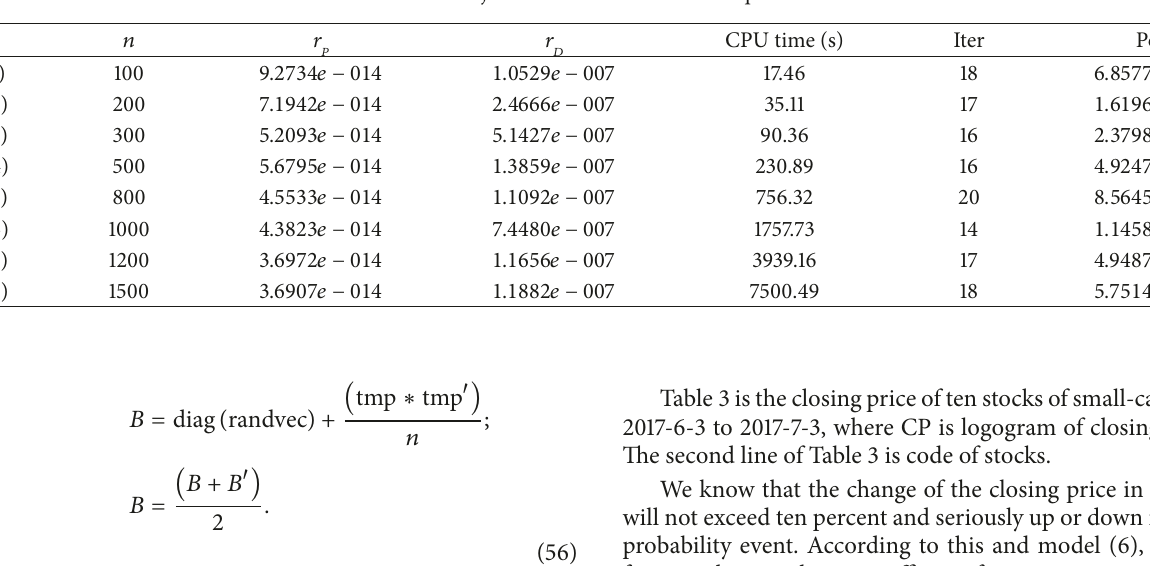
Table 2: Objective function is stochastic